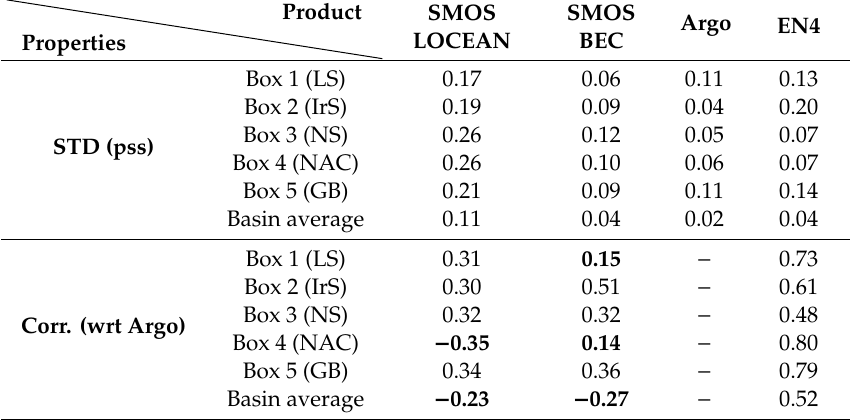
Table 3. SD and correlation of the time series of monthly mean SSS anomalies averaged over the five selected boxes and the entire SPNA basin for the period of 2013–2019. The data record for 2011–2012 was not included due to the large drift in SMOS products. The correlation coe ffi cients in bold indicate that they were not statistically significant at the confidence interval of